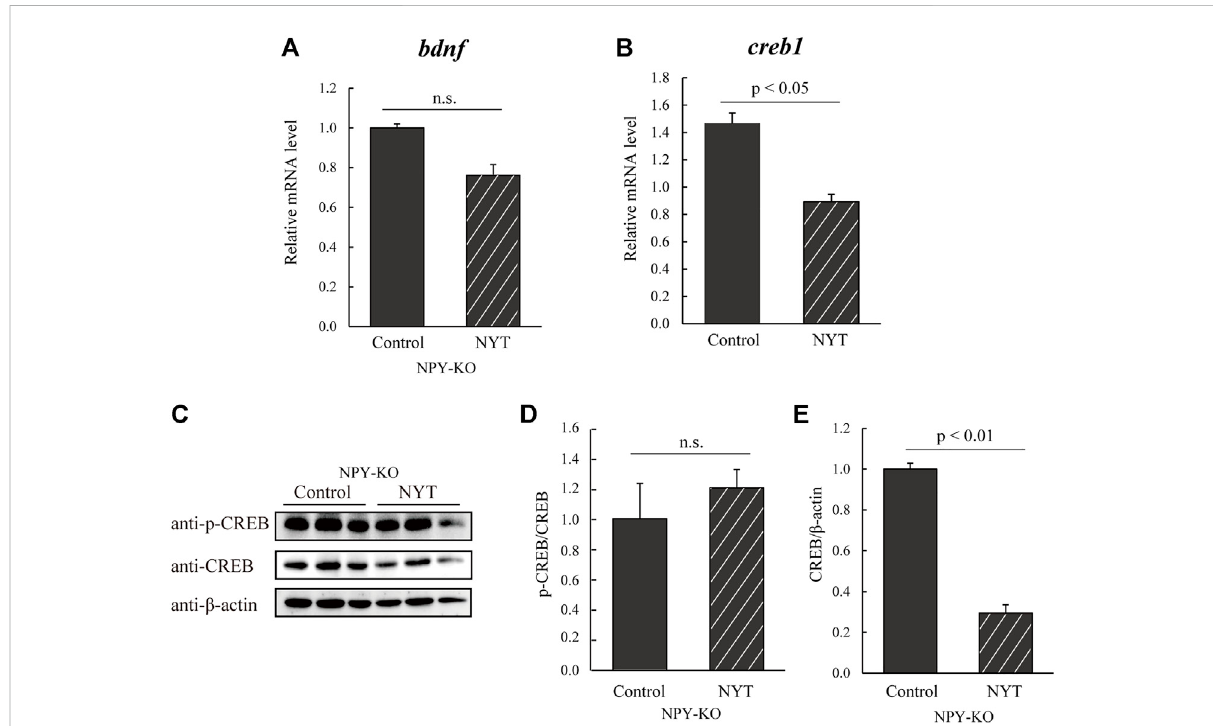
Effect of NYT on BDNF/CREB in NPY-KO zebra fi sh. The mRNA levels of bdnf and creb1 were estimated by real-time PCR using the whole brain of the control — and NYT-fed NPY-KO zebra fi sh. (A) bdnf . (B) creb1 . The gene expression level of actb was used as an internal reference. Each gene expression level was relative to that in the control-fed NPY-KO zebra fi sh. n = 5. The protein levels of (C,D) p-CREB and (C,E) CREB were analyzed using immunoblotting with whole-brain lysates of control — and NYT-fed NPY-KO zebra fi sh. The loading control used was (D) total CREB and (E) β -actin. n = 4. Results are shown as mean ± standard error of the mean. n.s., not signi fi